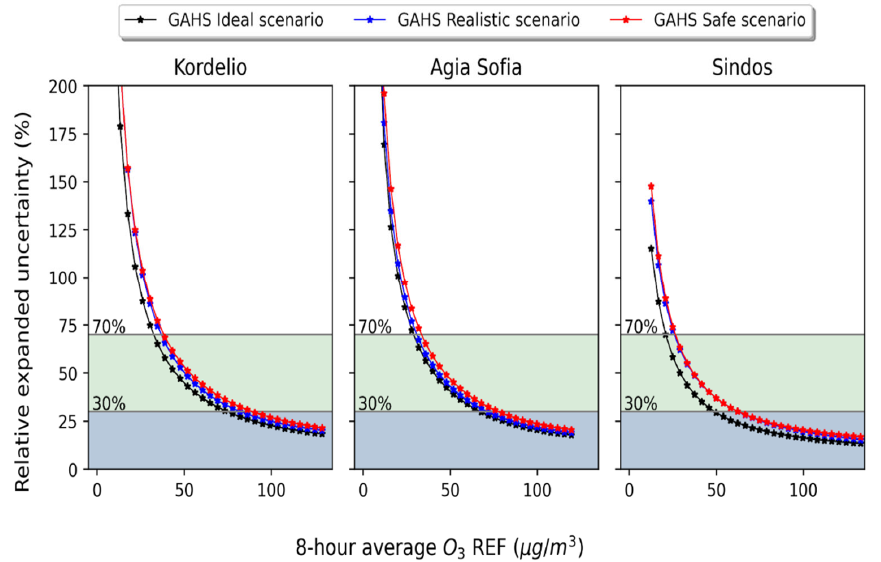
Figure 7. The effect of delaying the training of the online models to the meta learners REU for O 3 for the three locations where reference LCS are collocated with reference instruments. The curves are exponential fits on the results.